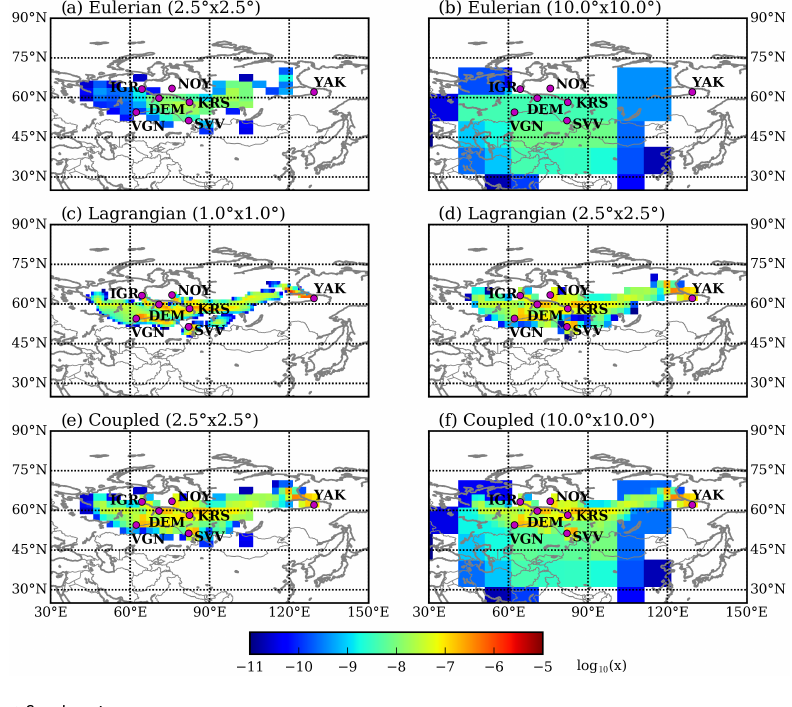
Figure 9. As for Fig. 8, but for day